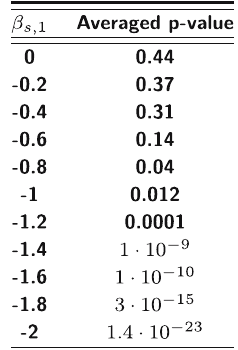
and the p - value of a Box - M test. The s ,1 s ,1 ≔